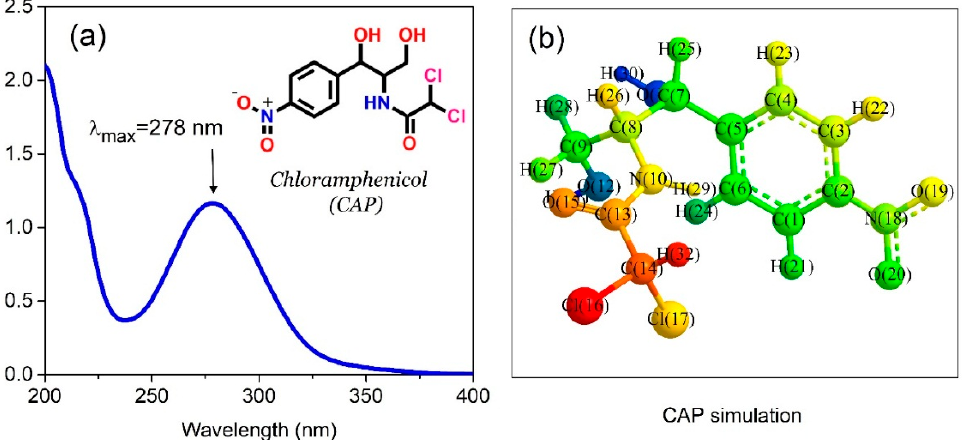
Figure 1. UV-Vis spectra ( a ) and structural formula ( b ) of chloramphenicol (CAP) simulated by molecular dynamics from the Chem3D program. Table 1. Several properties of chloramphenicol (CAS No. 56-75-7). Chemical